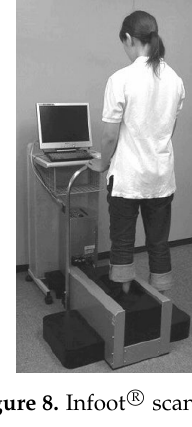
Figure 8. Infoot R (cid:13) scanner.